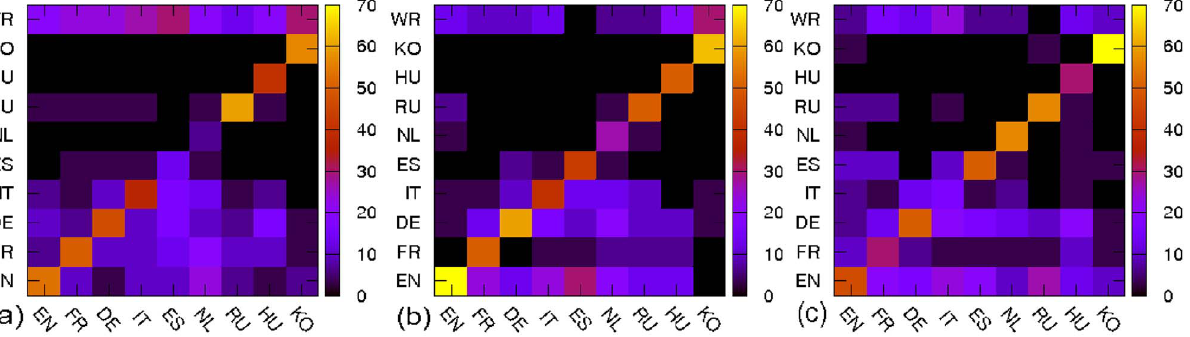
Figure 4. Distributions of top 30 persons over different cultures corresponding to Wikipedia editions, ‘‘WR’’ category represents all other cultures which do not belong to considered 9 Wikipedia editions. Panels show ranking by (a) PageRank, (b) 2DRank, (3) CheiRank. The color bar shows the values in percents. doi:10.1371/journal.pone.0074554.g004 PLOS ONE |